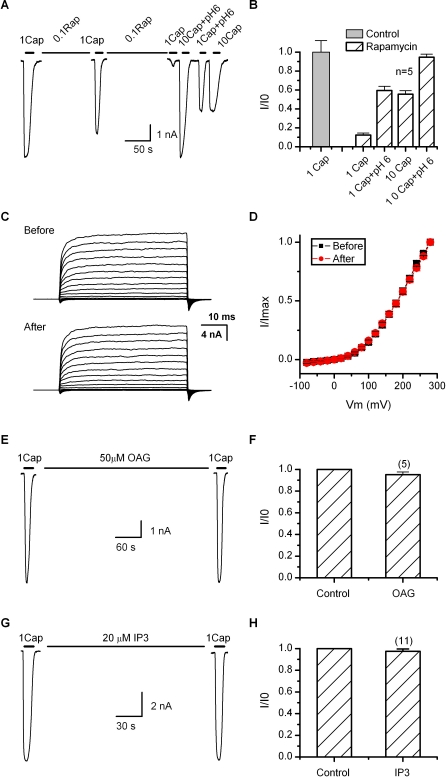
Effect of PIP2 on TRPV1(A) Representative time traces showing the stimulation protocol. Cells were locally perfused with 0.1 μM rapamycin for ∼5 min including a brief interruption in the middle during which whole-cell currents were sampled by application of 1 μM capsaicin in the absence of Ca2+. At the end of the rapamycin treatment, several supramaximal stimuli including 10 μM capsaicin, 1 μM capsaicin plus pH 6, and 10 μM capsaicin plus pH 6 were applied to evaluate the responsiveness of the channel. Cells were cotransfected with TRPV1, the membrane-anchored FKBP/rapamycin-binding fusion protein Lyn-FRB, and a yeast PIP2 5-phosphatase chimera FKRB-Inp54p.(B) Average peak currents before and after rapamycin application. The treatment with rapamycin diminished the response of the channel to 1 μM capsaicin, partially preserved the responses to 10 μM capsaicin or 1 μM capsaicin plus pH 6, and fully retained the maximum response at 10 μM capsaicin plus pH 6.(C) Voltage responses before and after depletion of PIP2 using the rapamycin inducible system. Currents were elicited with 50-ms test pulses from −80 to +280 mV in 20-mV increments within same cells. V
h = −60 mV. Rapamycin was continuously applied for ∼5 min, and no capsaicin was applied throughout experiments.(D) Comparison of current-voltage relationships before and after depleting PIP2 (n = 6).(E–H) Experiments showing that the hydrolysis products of PIP2, OAG (DAG analog), and IP3, were ineffective on the channel function. OAG (50 μM) was delivered by local perfusion while IP3 (20 μM) was dialyzed into cells through patch pipette (waiting time >5 min).